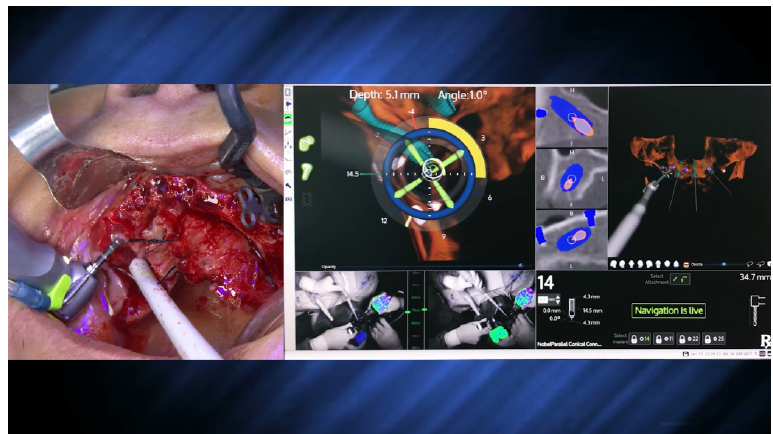
Figure 11. Perioperative preparation of the posterior implant (placed in a tilted position) with the 2.0 mm drill using live navigation. Note the data on the right-hand side considering depth and angle.